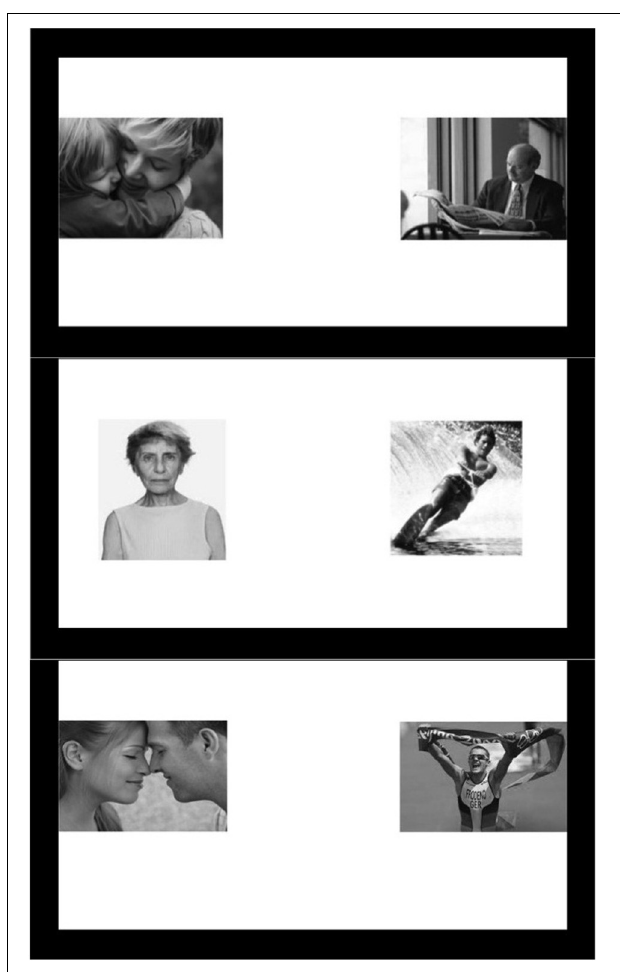
FIGURE 1 | Example of pictures used in each of three combination-conditions. ( Top : affiliative vs. neutral; Middle : incentive vs. neutral; Bottom : affiliative vs.